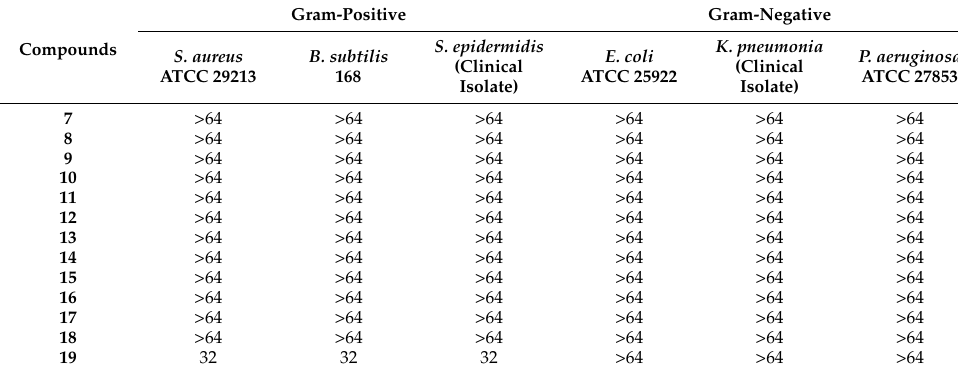
Table 2. In vitro biofilm-preventing activity of 2(5 H )-furanone derivatives 7 – 30 (BPCs, µ g/mL). The median values from five independent experiments are